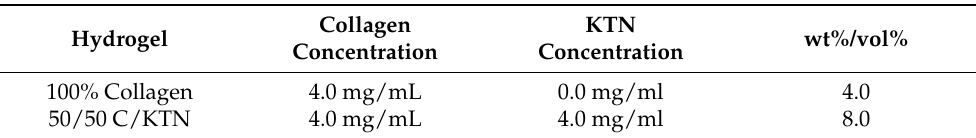
Table 1. KTN concentration and total protein concentration for each type of hydrogel. The concentra- tion of collagen remains constant. Collagen Hydrogel